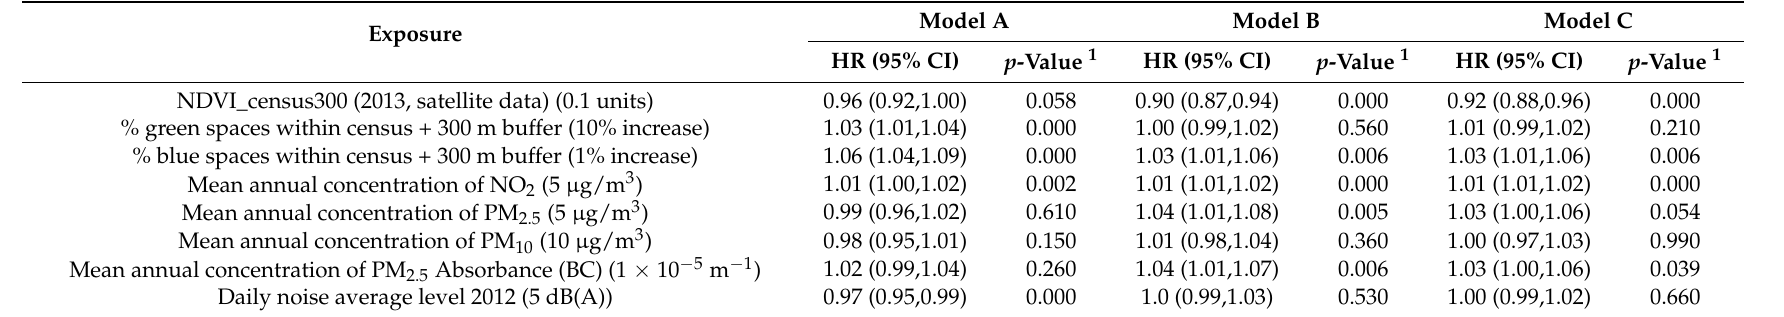
Table A1. Models of single pollutants (PM 2.5 , NVDI, GS, BS, Noise). Excluding movers. n =